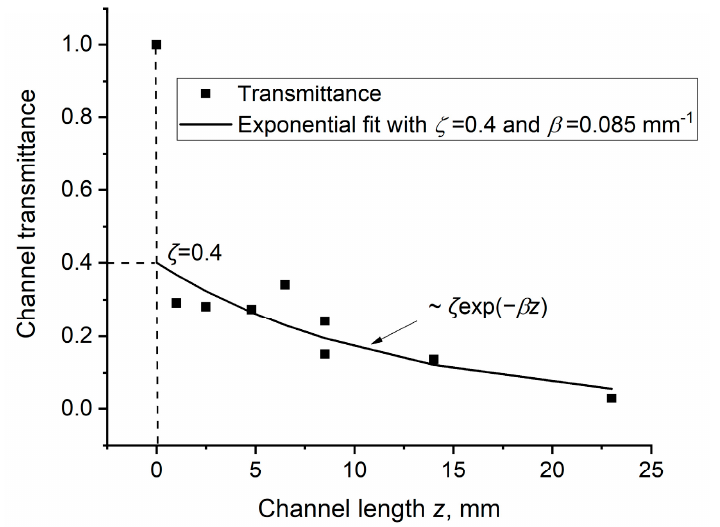
Figure 12. Channel transmittance and its dependence on PMMA thickness. The dots are measurements with calorimeters; the solid line is an exponential approximation with ζ = 0.4 and β = 0.085 mm − 1 .